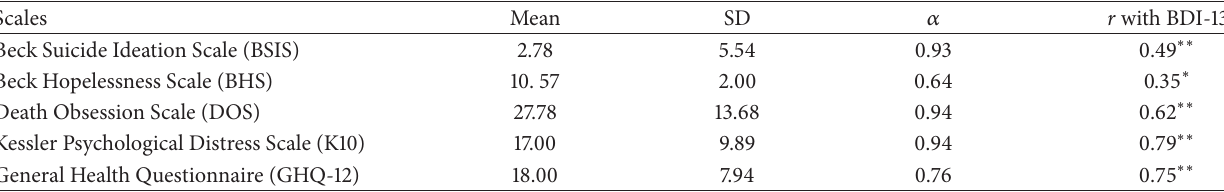
Table 3: Descriptive statistics of all scales and correlations with the BDI-13.